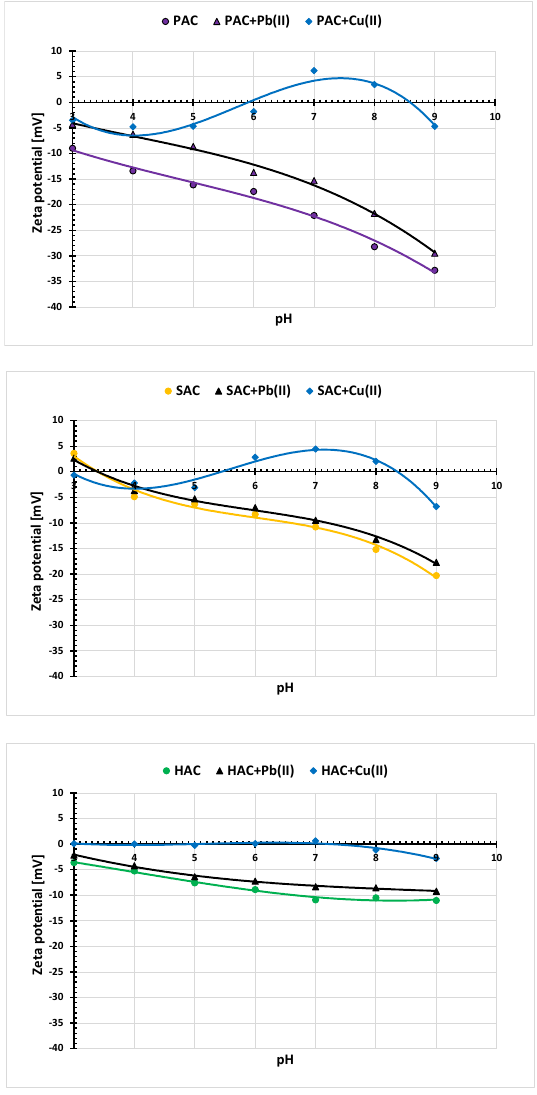
Figure 9. Zeta potential of PAC, SAC and HAC solid particles without and in the presence of heavy metals ions; C 0 10 mg/dm 3 .